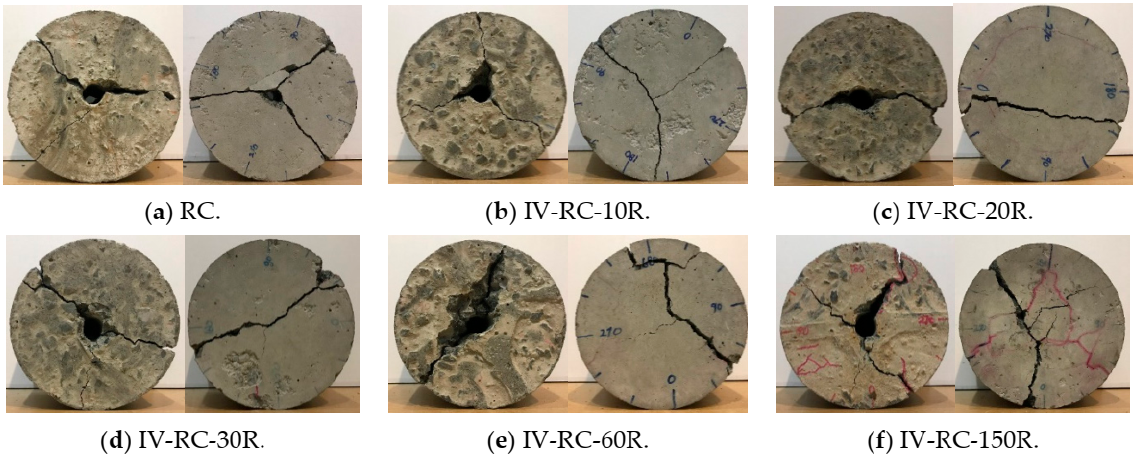
Figure 17. Failure state on top and bottom faces of series IV specimens after pullout